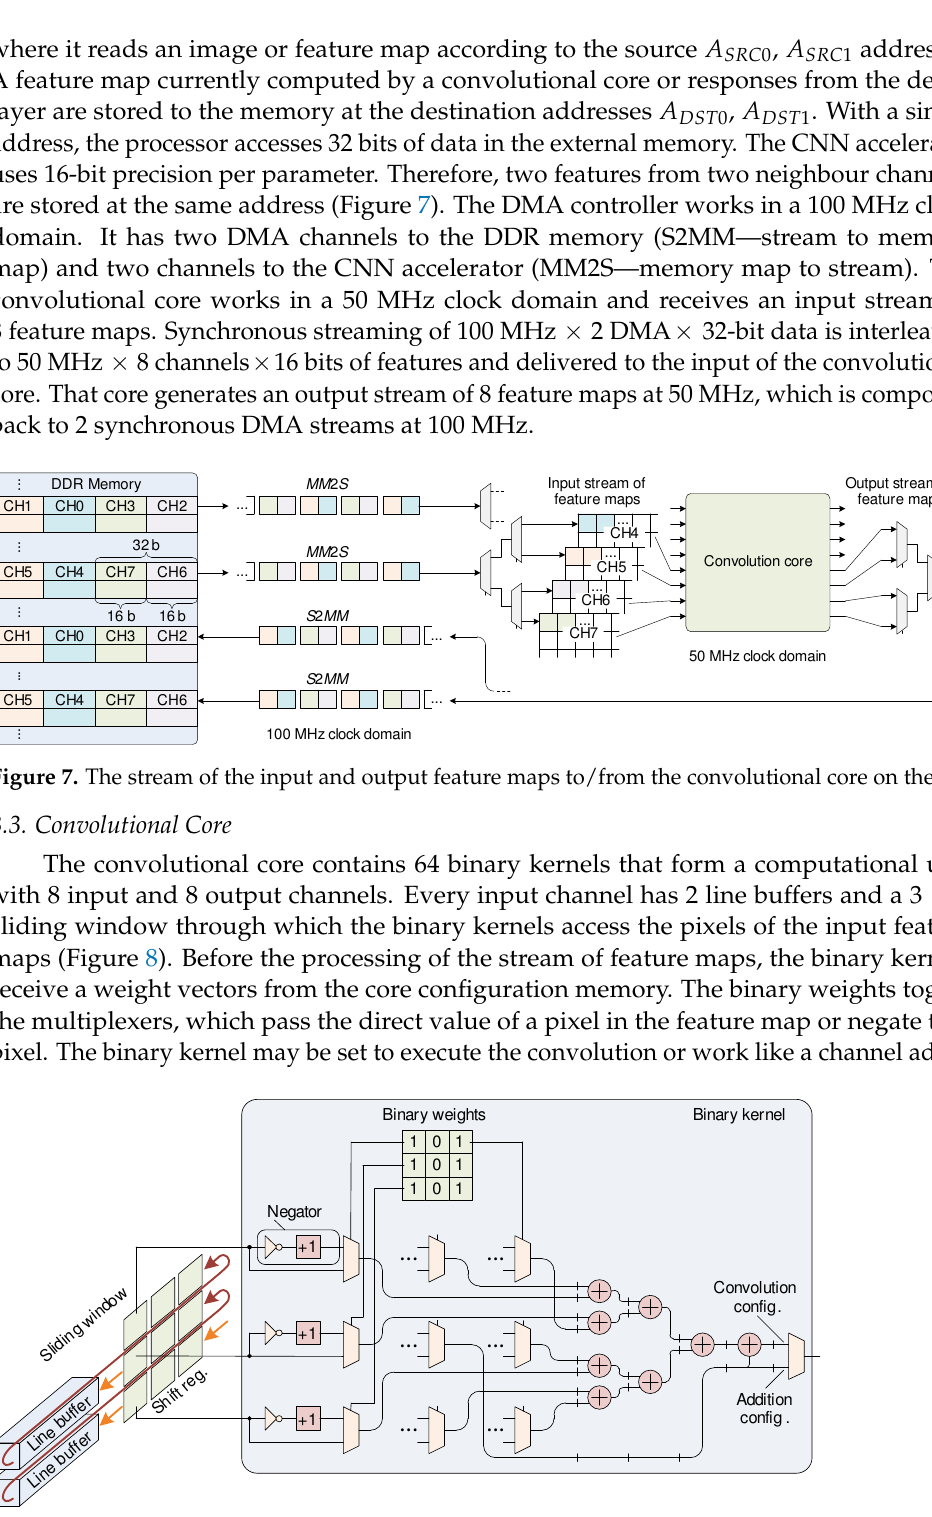
Figure 8. The binary kernel with a 3 × 3 sliding window for convolution/addition core configuration. The product of the binary kernel goes to the modified batch normalization block (Figure 9). The parameter K c = kA c contains a scaling factor A c of the c th kernel (2), and k includes all the parameters related to batch normalization [31]. Parameter b adds an offset on the output channel of the binary kernel. The batch normalized product goes to